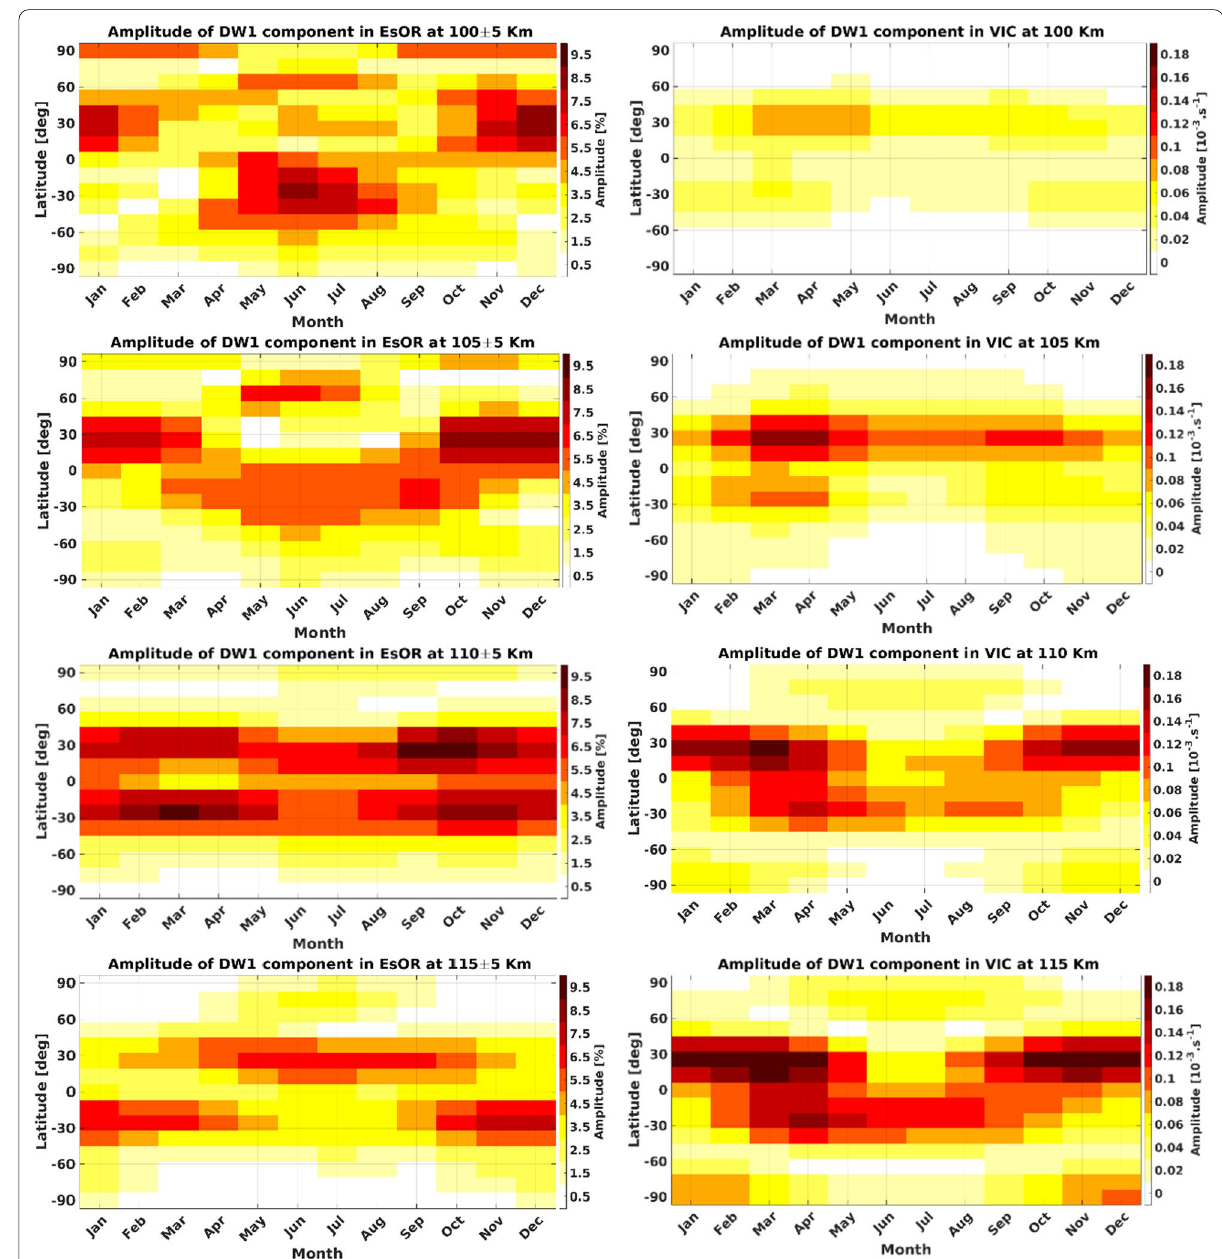
Fig. 5 Month‑to‑month amplitude variation of DW1 component of tides in EsOR (left column) and VIC (right column) at different